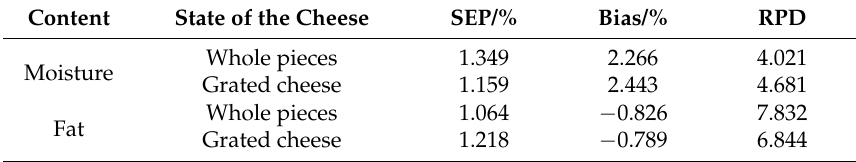
Table 5. SEPs and Biases for the pre-established "dairy products" model in the SCiO app. Content State of the Cheese SEP/% Bias/% RPD Whole pieces 1.349 2.266 4.021 Moisture Grated cheese 1.159 2.443 4.681 Whole pieces 1.064 − 0.826 7.832 Fat Grated cheese 1.218 − 0.789 6.844 SEP—Standard error of prediction; RPD—Ratio of performance to